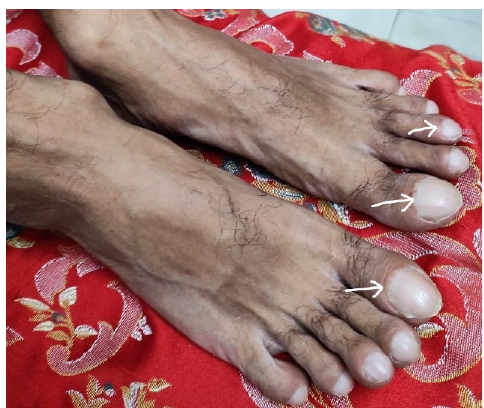
Figure 2. Clubbing of the fingers, marked with arrows.